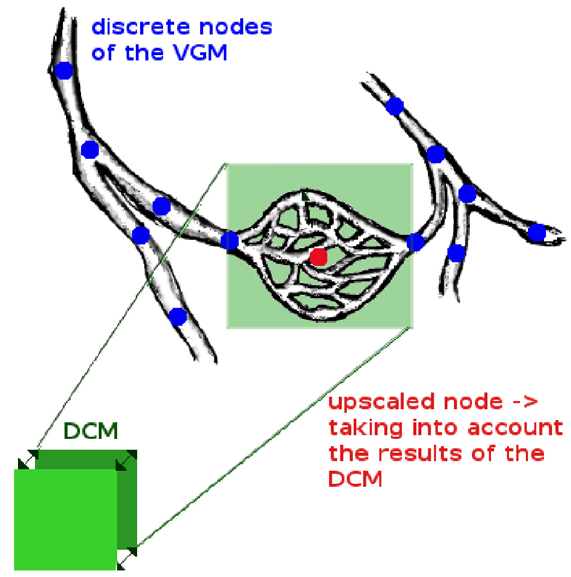
Figure 9. Concept for the coupling of the DCM to the VGM.